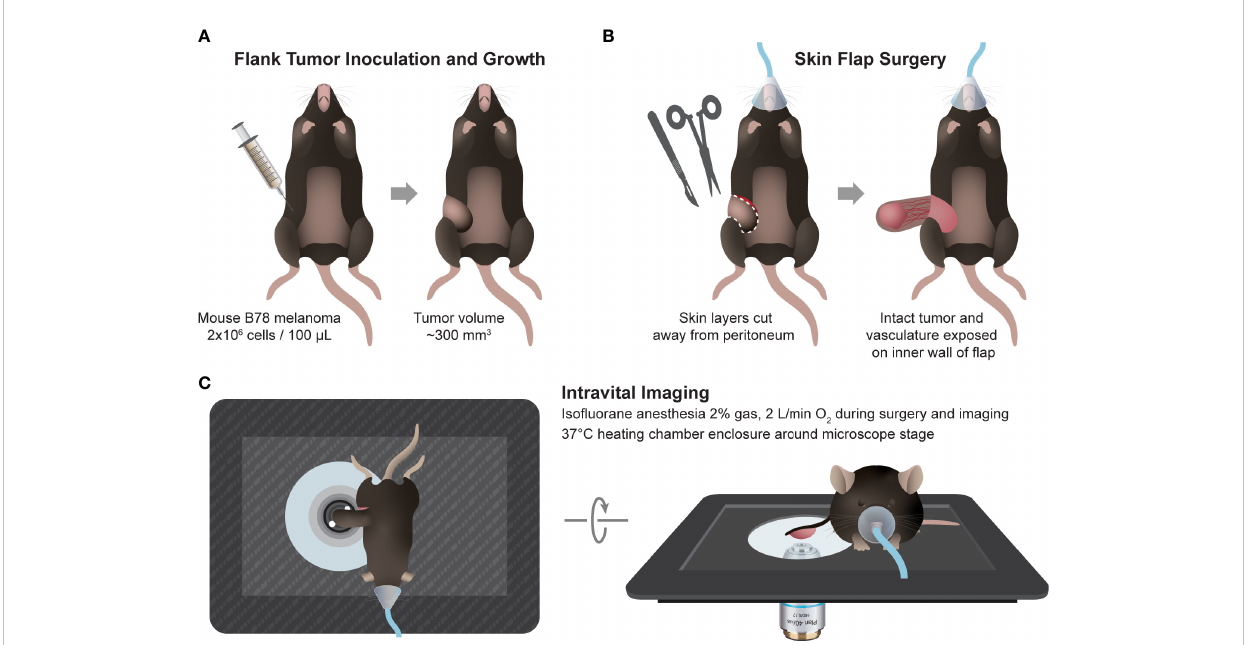
FIGURE 1 In vivo multiphoton imaging experimental work fl ow. (A) Work fl ow began with intradermal inoculation of 2×10 6 B78 melanoma cells on mouse fl ank. Tumors were monitored weekly until they reached ~300 mm 3 volume. (B) On the day of imaging, the mouse was anesthetized, and tumor skin fl